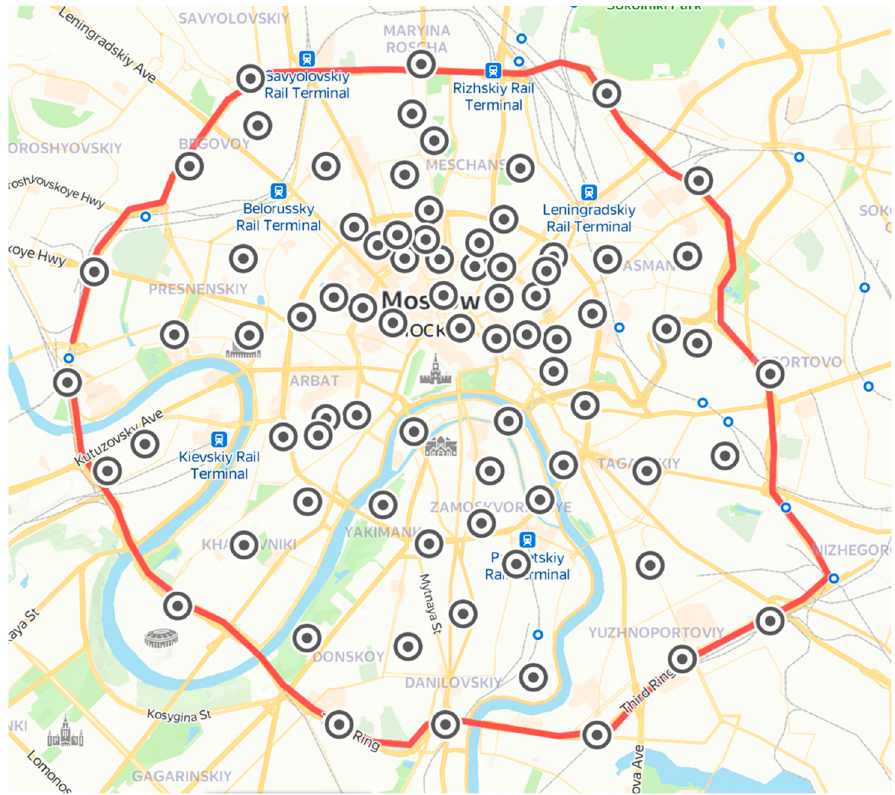
Figure 4. Map of the Moscow downtown with indicated dust sampling sites. Red line indicates the Third Transport Ring.